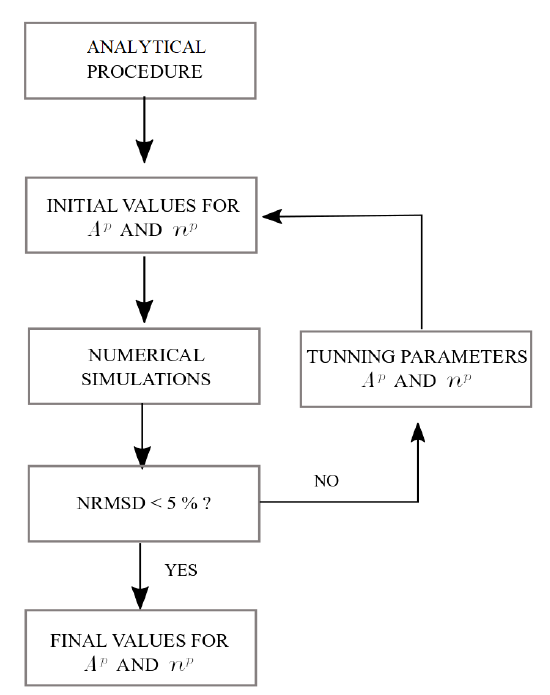
Figure 9. Iterative experimental–numerical procedure to obtain the hardening parameters A p and n p .